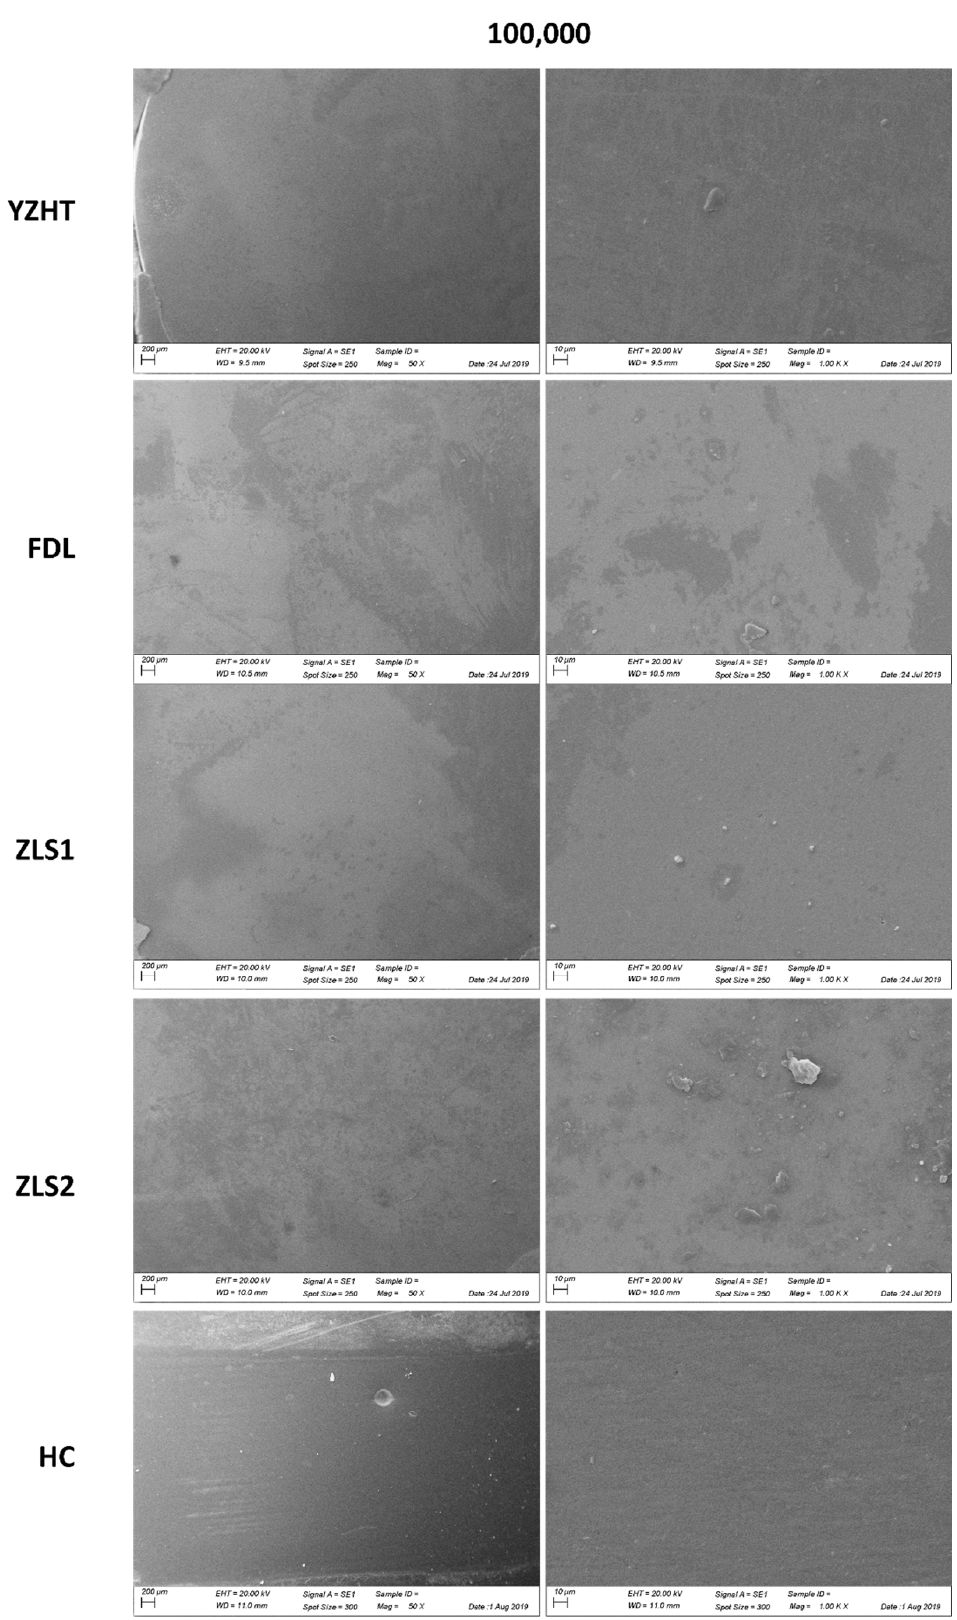
Figure 4. Scanning electron microscopy of surface topography with 50× and 1000× magnification according to the ceramic material (YZHT, FDL, ZLS1, ZLS2 and HC) for 10 years of evaluation.